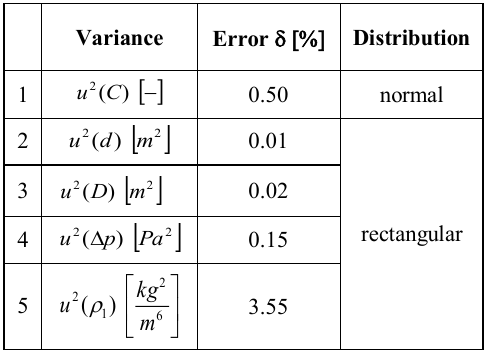
Table 2 . The values of the relative errors  . 